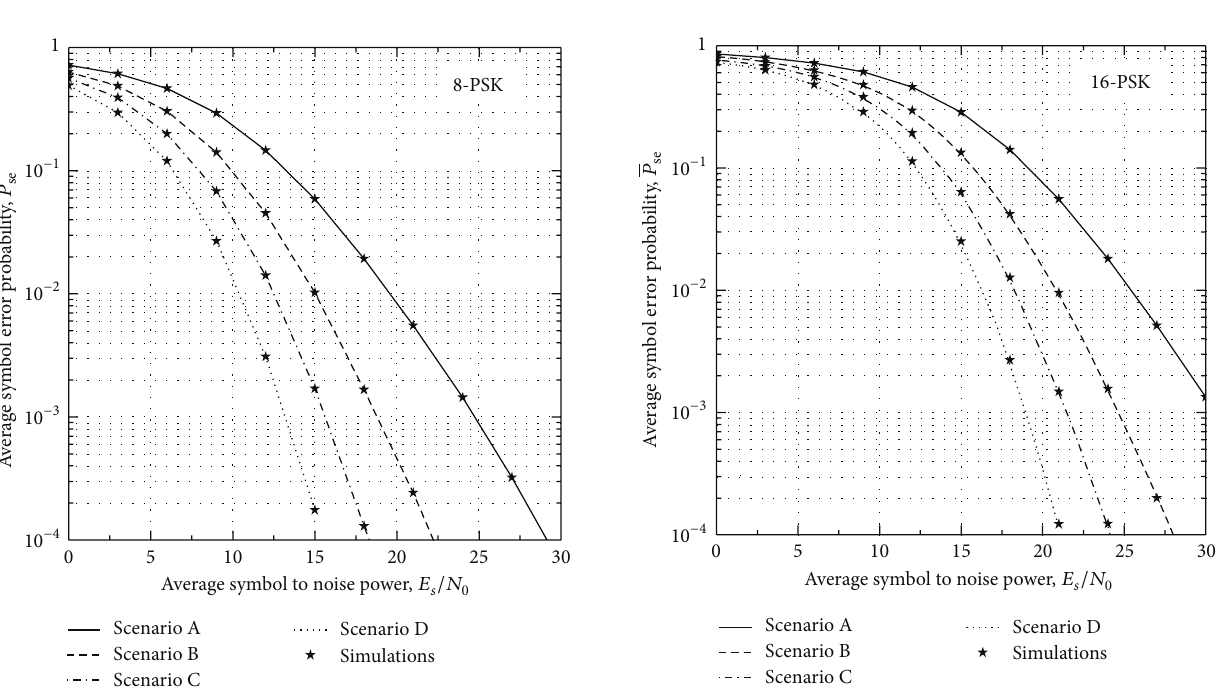
Figure 2: Average symbol error probability, 𝑃 , of 8 -PSK of dual- se hop DF relaying with RS as a function of the average symbol to noise power, 𝐸 𝑠 /𝑁 0 , for 𝐿 = 3 relays and various Nakagami- 𝑚 fading